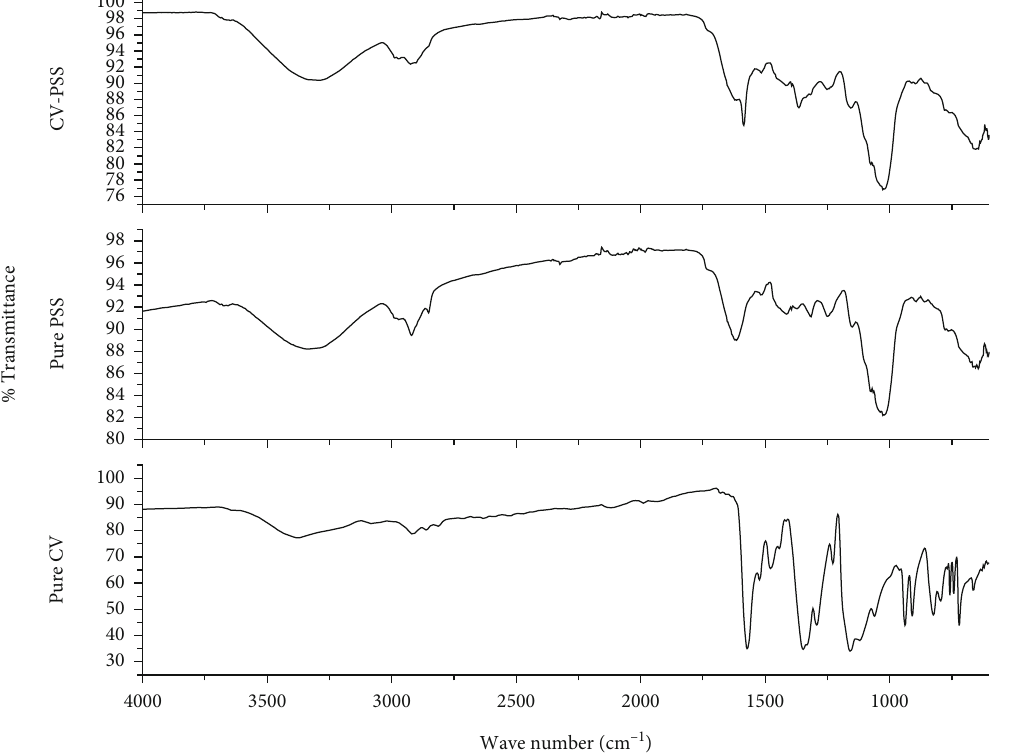
Figure 3: FTIR spectrum of (a) CV, (b) PSS, and (c) CV adsorbed